Question: What does this figure show? Answer in one sentence.
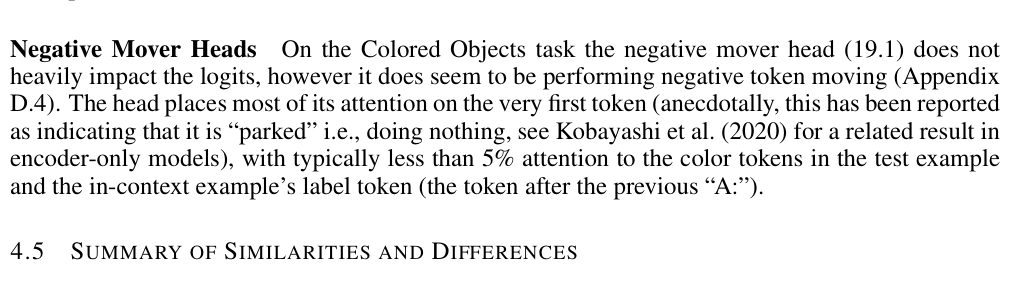
Answer: Left: The full graph of attention heads with the difference of the path patching importance scores between each task (normalized by task per each path patching iteration). Middle: Visualizing only the union of the top 2% most important heads (per path patching stage) for each task, colored by the difference in importance scores. Right: Explanation of each stage of processing in the circuit. Both circuits involve the same general process: detecting a duplication and using that duplication to decide which token to copy. In the Colored Objects task, the duplication is used as a “positive” signal via the content gatherer heads to tell the mover heads which token to copy, while in IOI the duplication sends a “negative” signal via the inhibition heads to tell the mover heads which tokens to ignore. These heads, and the activation of the negative mover head in IOI constitute the only major difference between the two tasks.